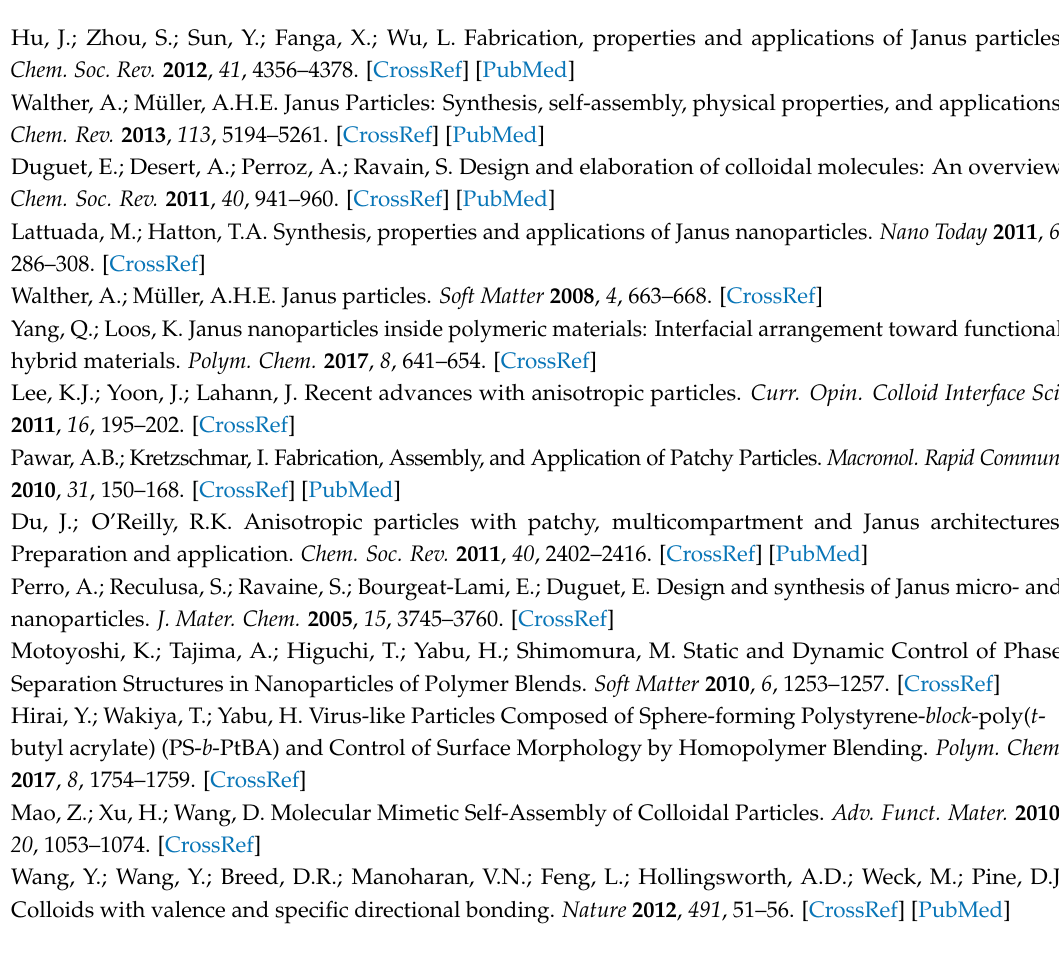
Figure S1: SEM images of polycondensation reaction at (a,b) 1 min, (c) 5 min (large agglomerate), (d) 15 min, (e) 30 min, (f) 60 min reaction time; additional synthetic